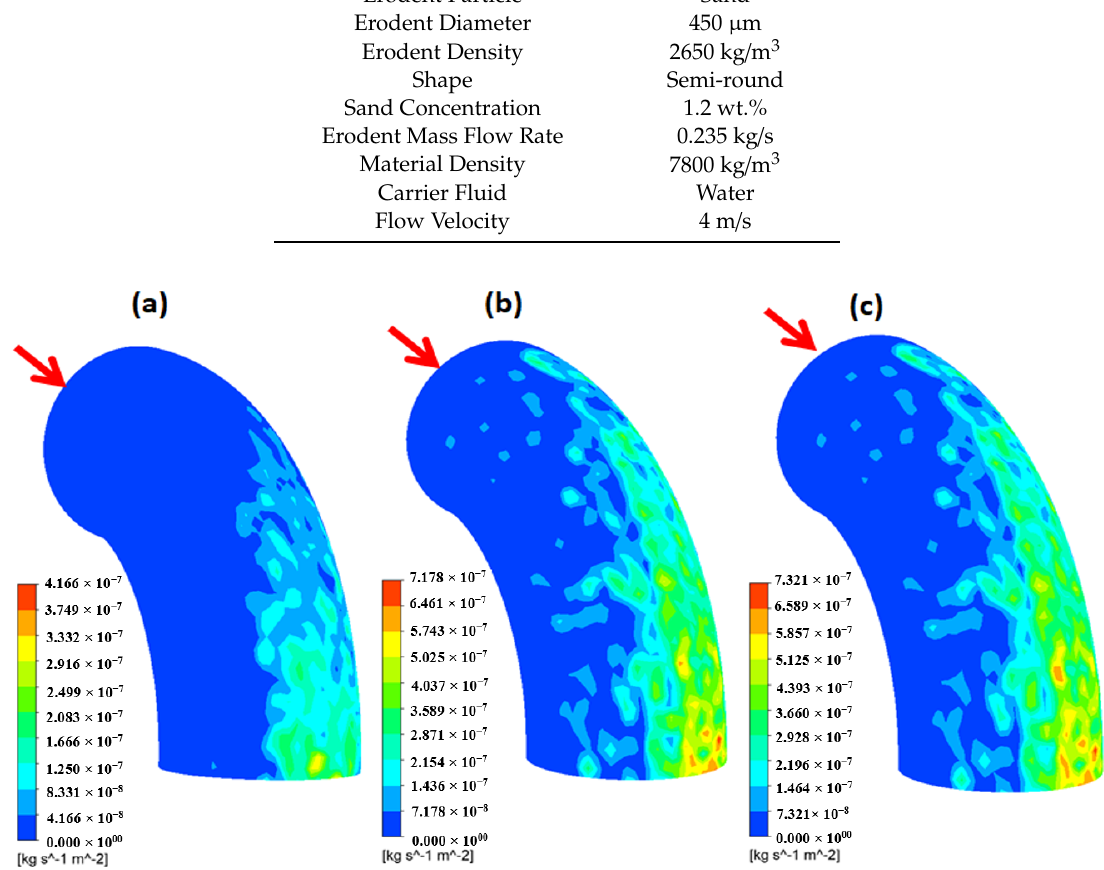
Figure 8. Predicted computational fluid dynamics (CFD) Erosion Using Three Different Meshes ( a ) Mesh 1 ( b ) Mesh 2 and ( c ) Mesh 3 . Table 4. Flow conditions for validation case.